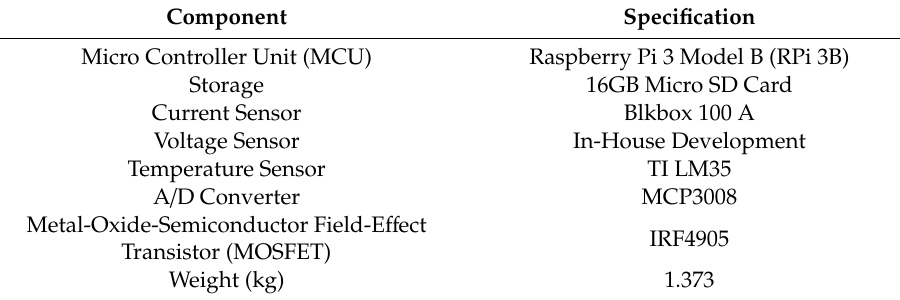
Table 1. Specifications of the hybrid power controller (HPC).